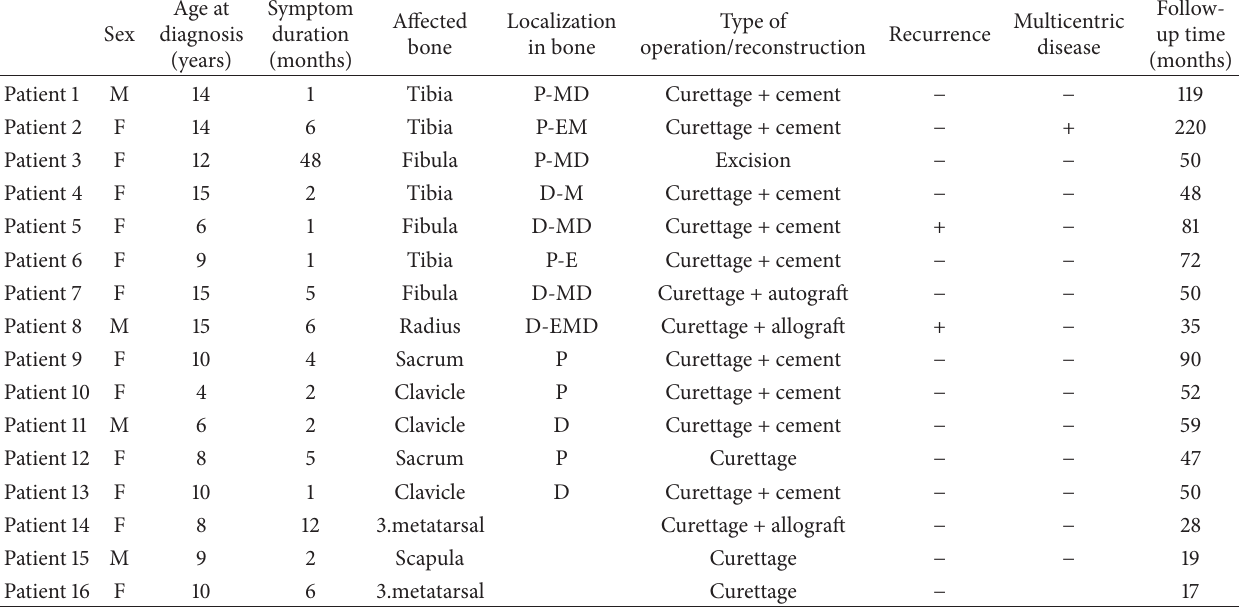
Table 1: Patient